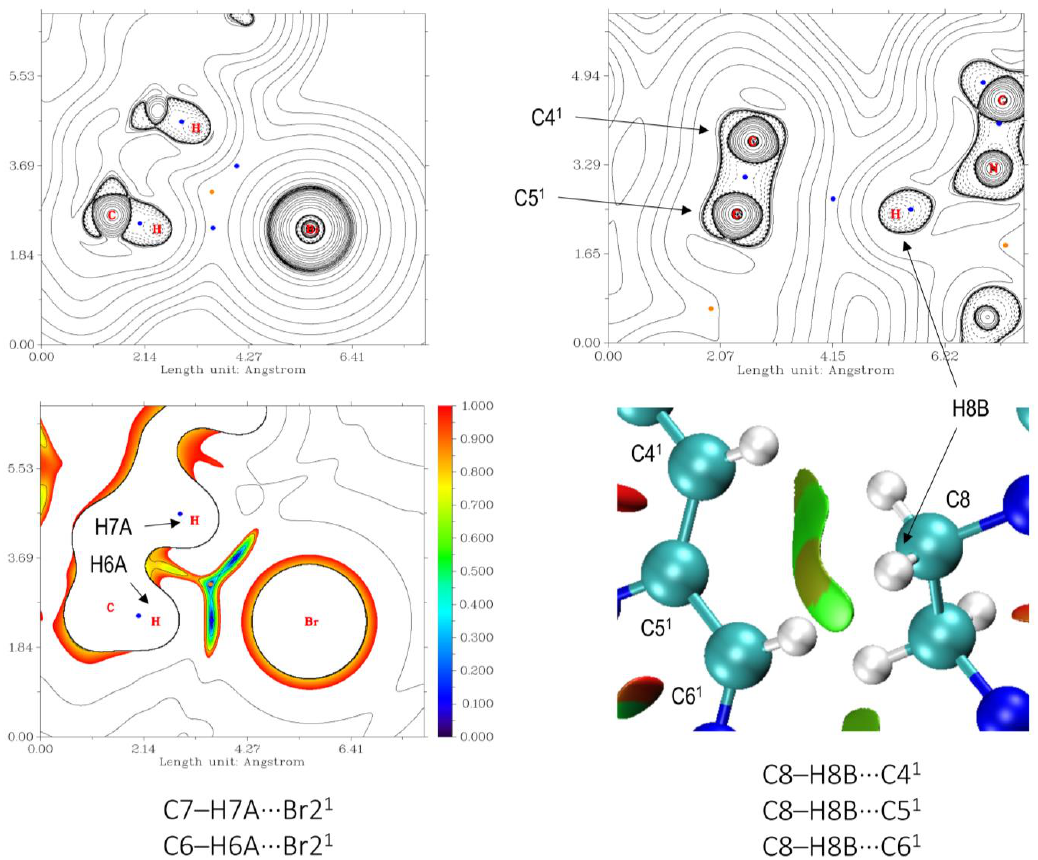
Figure 12. Top: plots of the Laplacian of the electron density in the real space, ∇ 2 ρ (r), for selected weak contacts. Bottom left: 2D cut plane of the RDG function for the same projection as in the top left plot. Bottom right: 3D isosurface of the RDG (isovalue of 0.5) illustrating non-covalent interactions in the H8B — C4 1 /C5 1 /C6 1 groups of atoms ( 1 = 1 – x, 1 – y, – z).